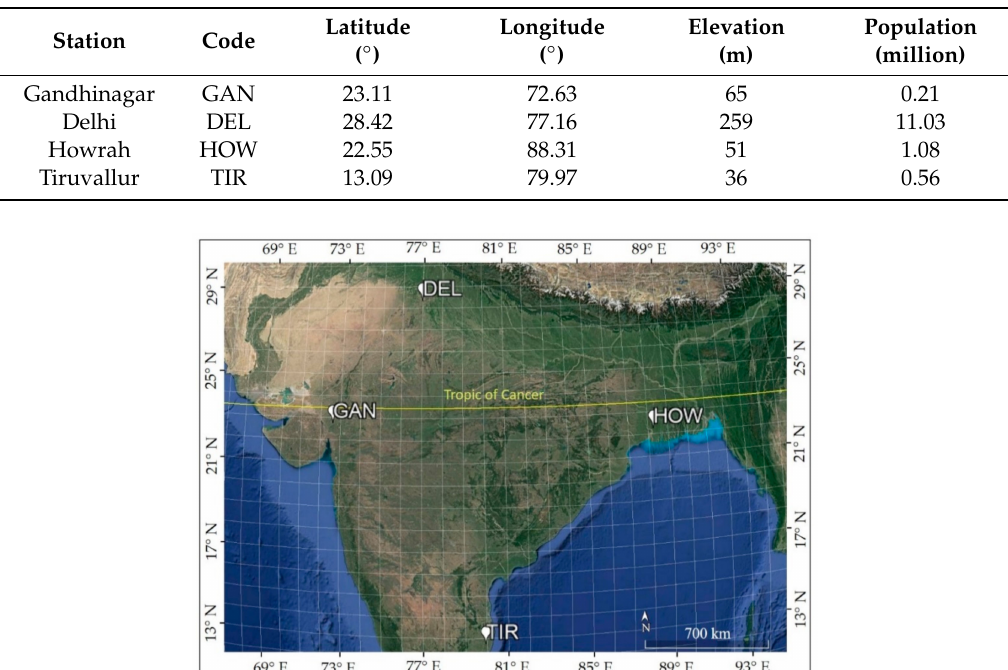
Table 1. Latitude (degrees), longitude (degrees), elevation (meters above sea level), of Baseline Surface Radiation Network (BSRN) stations located in India, along with population levels.